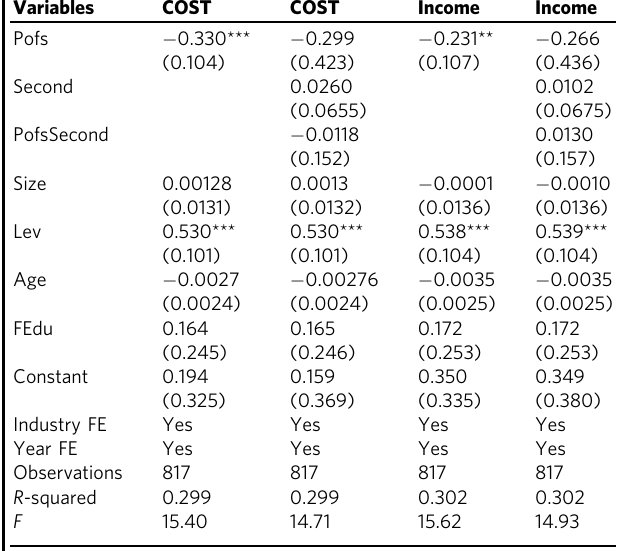
Table 6 Regression analysis on the impact of female employment and corporate performance under the two-child policy.